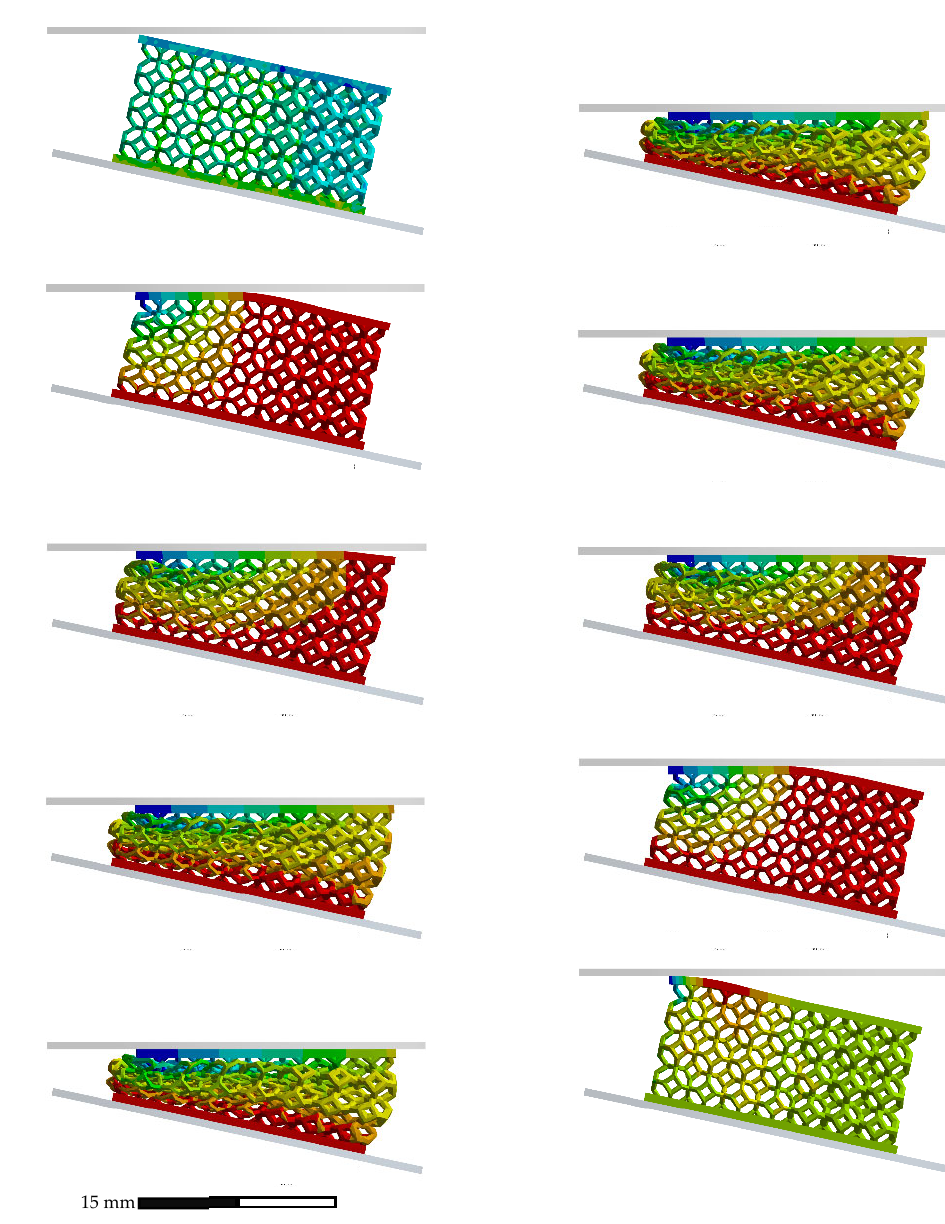
Figure 13. Impact sequence for side-graded lattice. Similar to the non-graded oblique impact case, the results for the inversed side-graded lattice were only numerical and are shown in Figure 14.